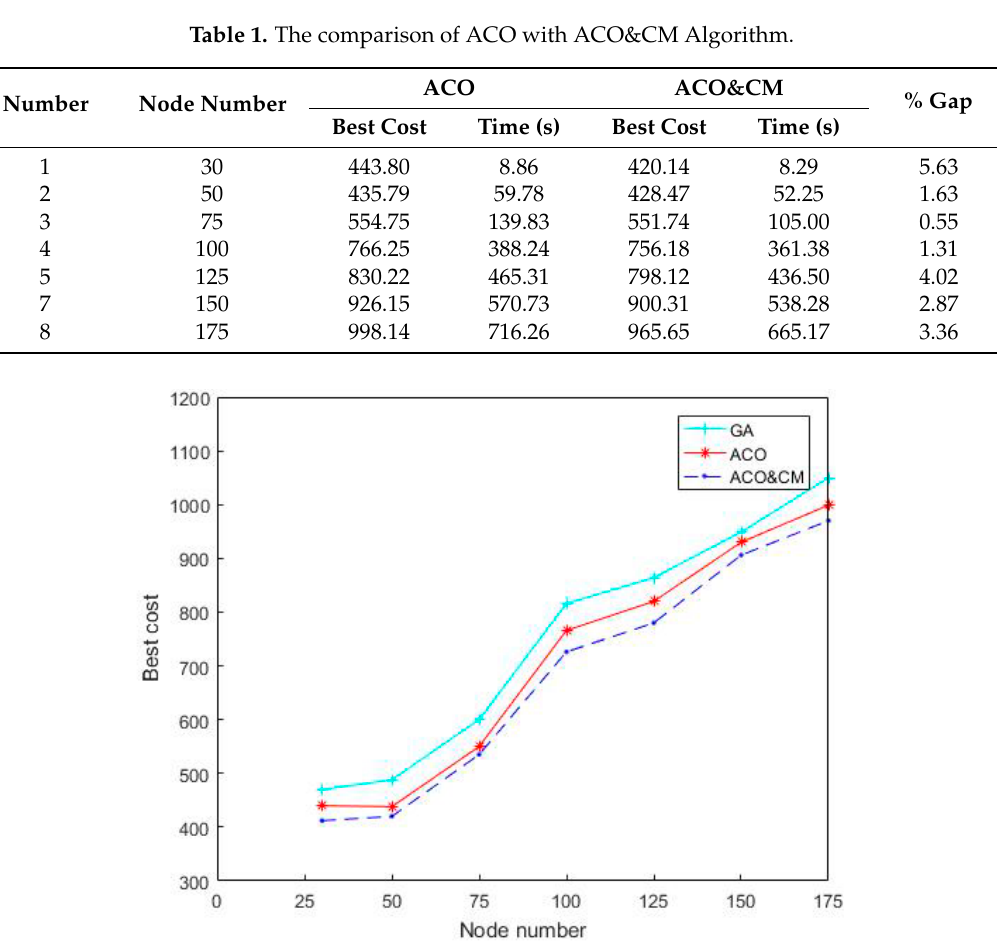
Figure 9. Comparison of the cost in different nodes.